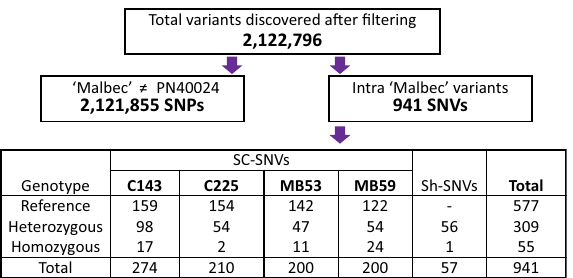
Figure 1. Total single nucleotide polymorphisms (SNPs) and single nucleotide variants (SNVs) identified in Malbec. SNPs were defined as variants that were common to the four clones, distinguishing Malbec from PN40024, whereas SNVs occurred differentially among the resequenced clones. SNVs were classified according to the clone for which they were identified and according to their genotype relative to PN40024. SC-SNVs are markers of variation in a single clone and Sh-SNVs are variants shared between two